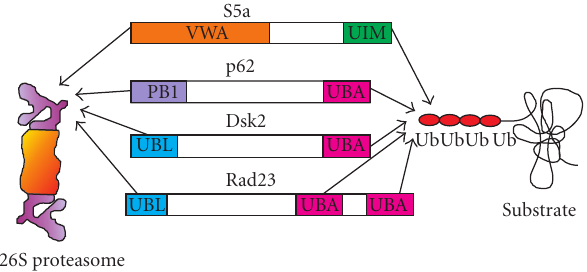
Figure 6: Presentation of ubiquitinated substrates to the 26S pro- teasome (see